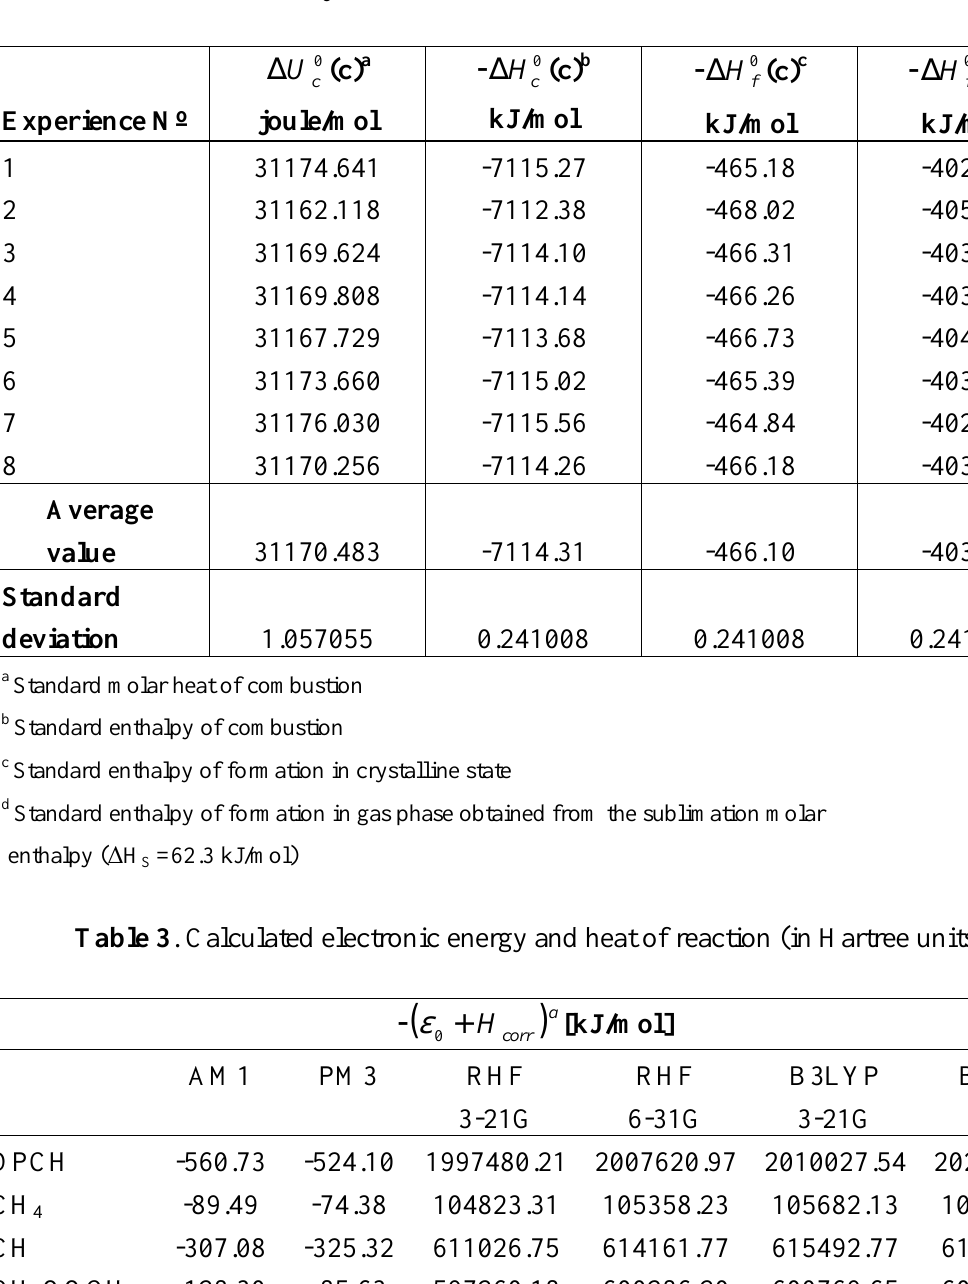
Table 2 . Summary of experimental specific heats of combustion and standard molar thermodynamic function of DPCH at T = 298.15 K.